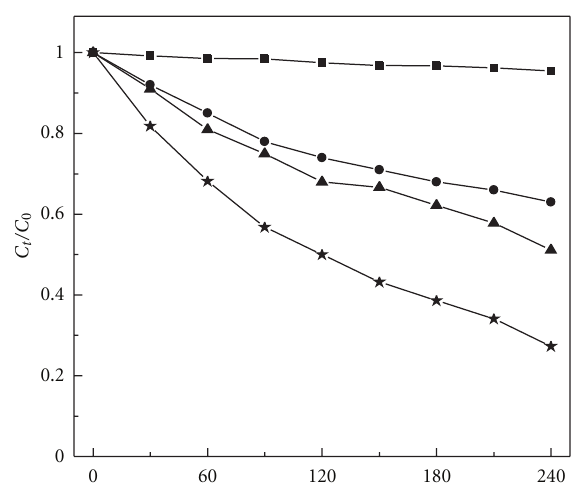
Figure 9: The residual fraction of MB in solution as a function of irradiation time with ( (cid:4) ) C-TiO 2 (UV), ( (cid:3) ) C-TiO 2 (200), ( (cid:2) ) TiO 2 (500), and ( • ) N-TiO 2 .